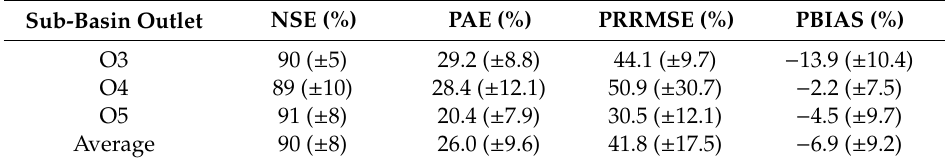
Table 4. Average statistical tools at the sub-basin outlets of the Tsurumi River Basin for the case of convective rain (CR) events.